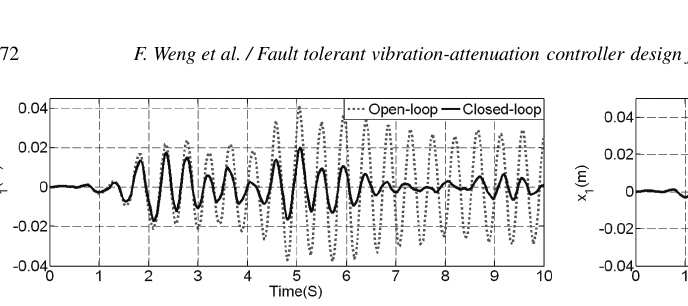
Fig. 2. Displacements of the first storey in case A1 ( τ = 25 ms). Fig. 3. Displacements of the first storey in case A2 ( τ = 25 ms).